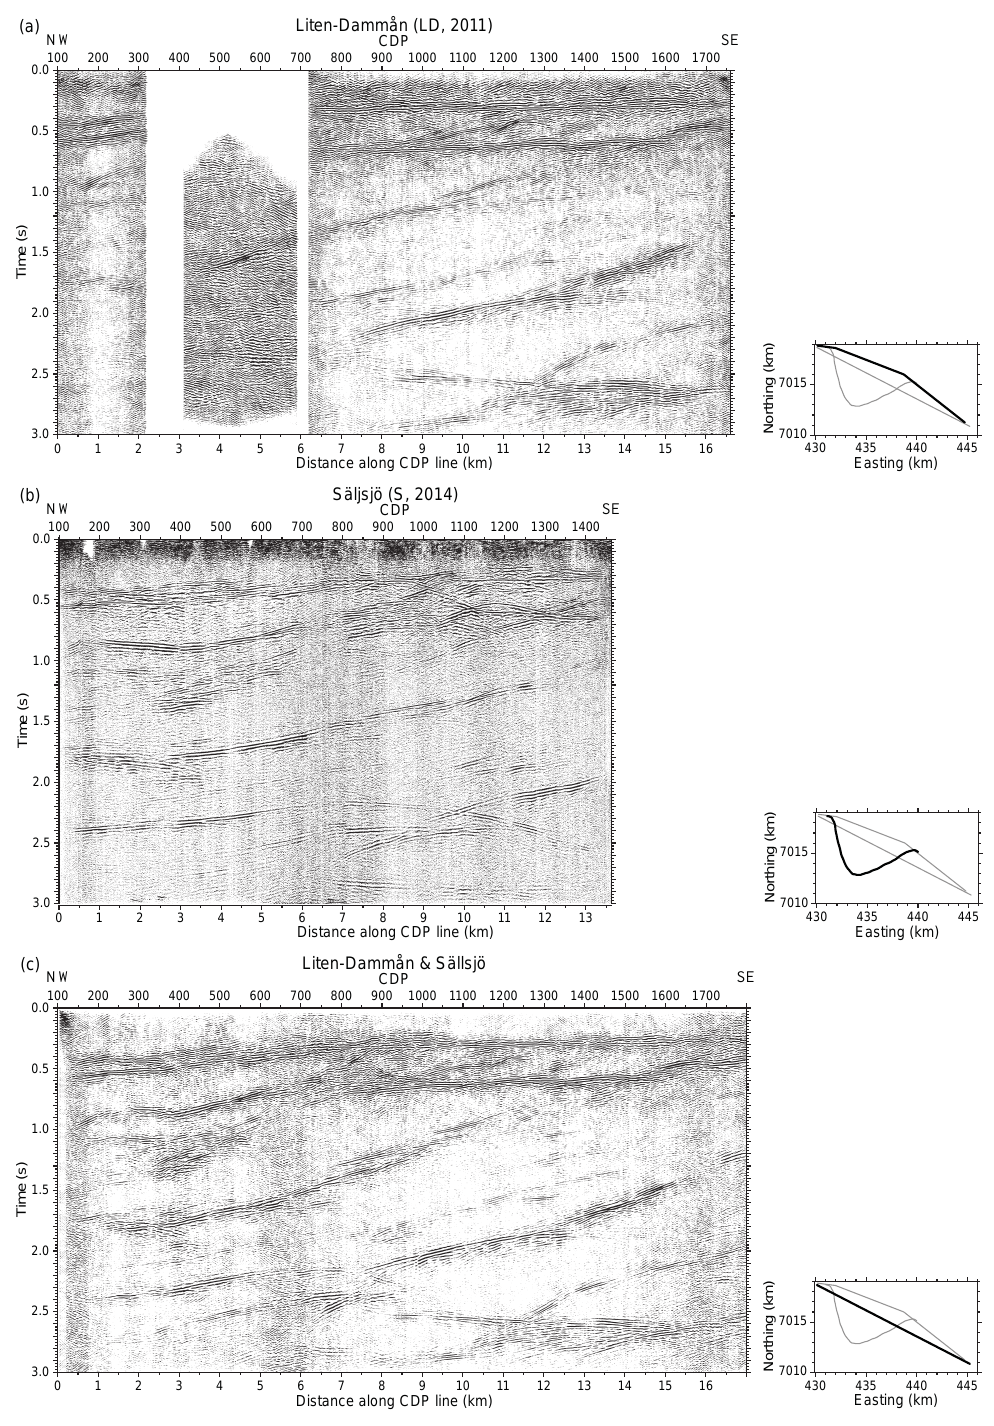
Figure 5. (a) Stacked section from the Liten-Dammån profile acquired in 2011 with the VIBSIST source. (b) Stacked section from the Sällsjö profile acquired in 2014 with the weight drop source. (c) Data from the Liten-Dammån and Sällsjö profiles processed together and stacked. The plan view maps show the three CDP stacking lines used, with the thick black line indicating the CDP stacking line corresponding to the section shown in the same panel. Panels (a) and (c) follow similar CDP stacking lines, while (b) follows a highly crooked CDP stacking